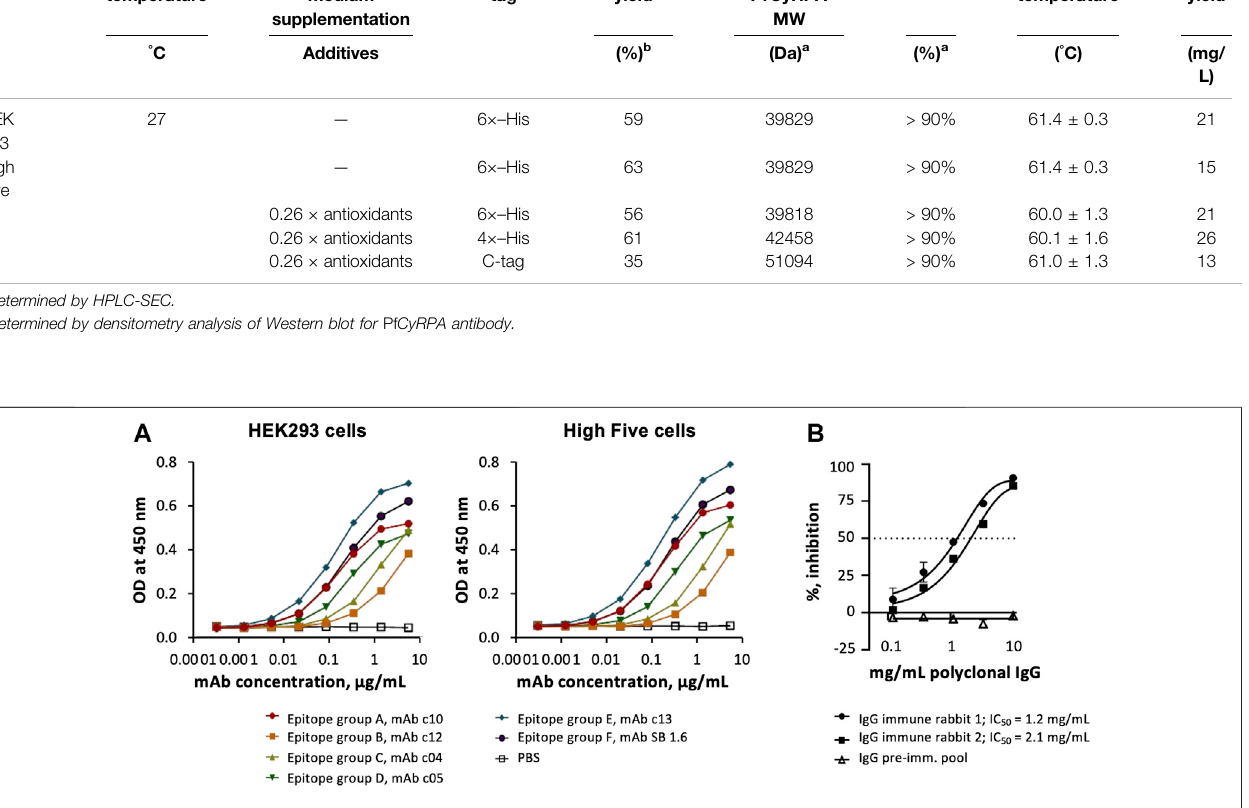
FIGURE 3 | Antigenicity and immunogenicity of Pf CyRPA produced in insect and mammalian cells. (A) Binding of anti- Pf CyRPA mAbs recognizing different epitopes on puri fi ed Pf CyRPA protein by ELISA. (B) In vitro parasite growth-inhibitory activity of polyclonal IgG antibodies generated in rabbits upon immunization with High Five cells derived Pf CyRPA. Data are shown as mean ± standard deviation of triplicate wells of a single assay, and are representative of two independent runs. For each IgG preparation a four-parameter sigmoidal dose – response curve was fi tted to the relationship between log 10 (antibody concentration) and % inhibition and then used to interpolate IC 50 values (antibody concentrations giving 50% growth